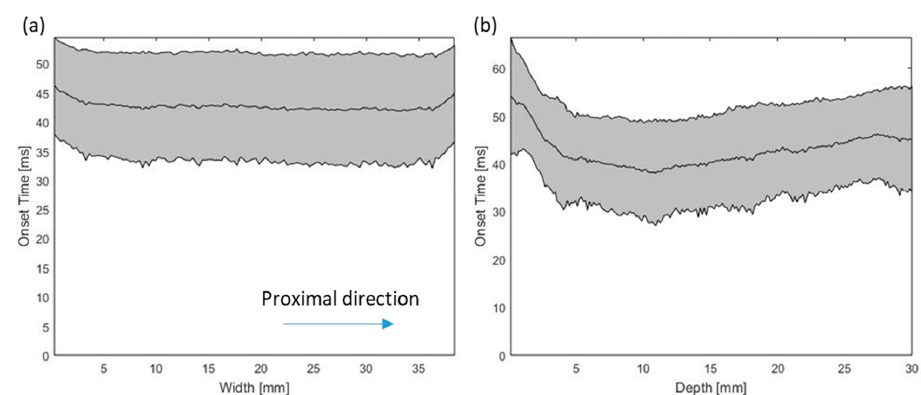
Figure 5. Mean onset time at different ( a ) widths and ( b ) depths of ultrasound image in longitudinal view. Grey area represents plus and minus one standard deviation at each position. Table 1. Pairwise comparison between onset time at different muscle depths (along the depth of the image shown in Figure 3A, with D1 as the most superficial layer and D5 as the deepest layer. * p < 0.05, ** p < 0.01, *** p < 0.001, NA: not applicable, NS: no significant difference. p -value corrected using Bonferroni correction.